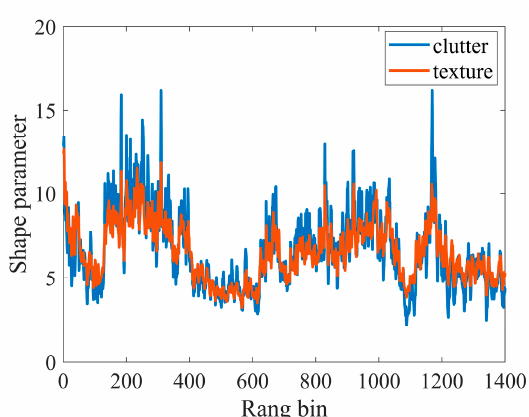
Figure 3. Shape parameters of real clutter and texture in different range bins.